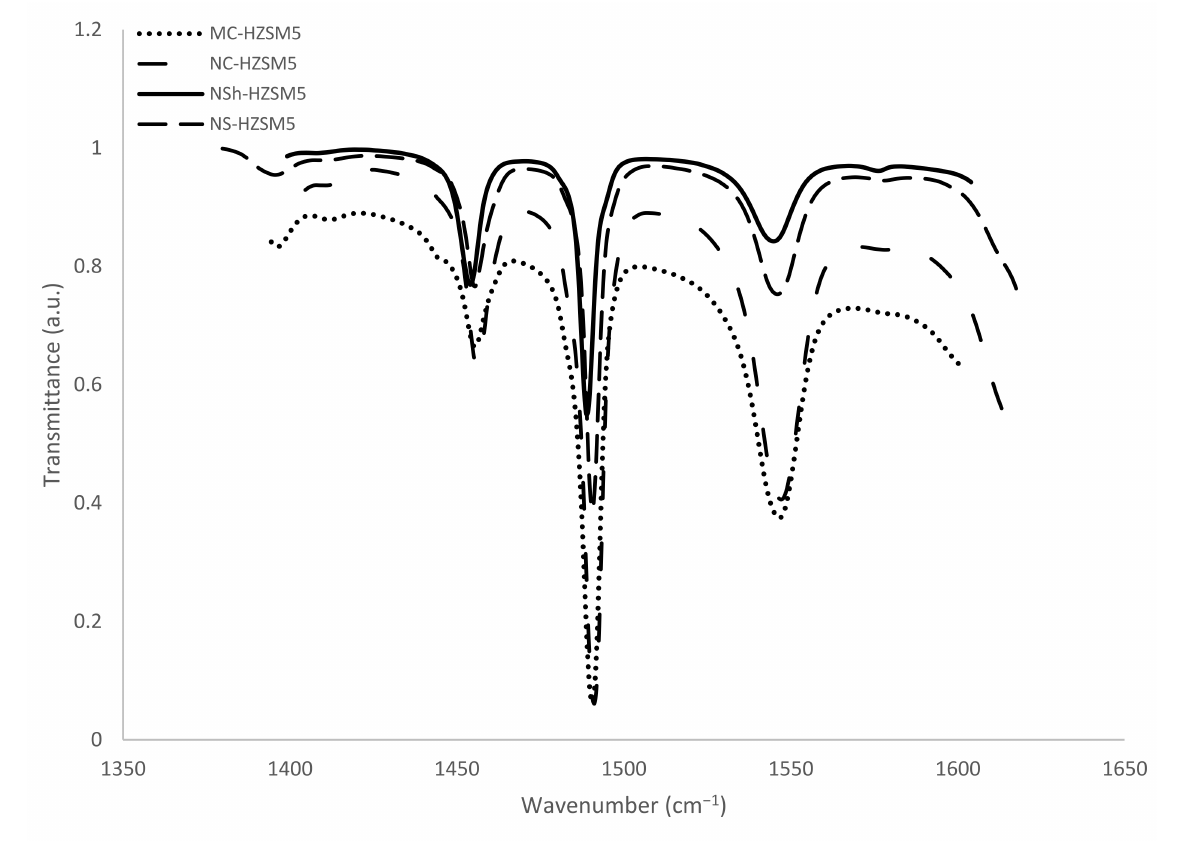
Figure 5. FTIR spectra upon the saturation of zeolites with pyridine, followed by the desorption at 150 ◦ C. Table 2. Brønsted and Lewis acidity of the produced HZSM-5